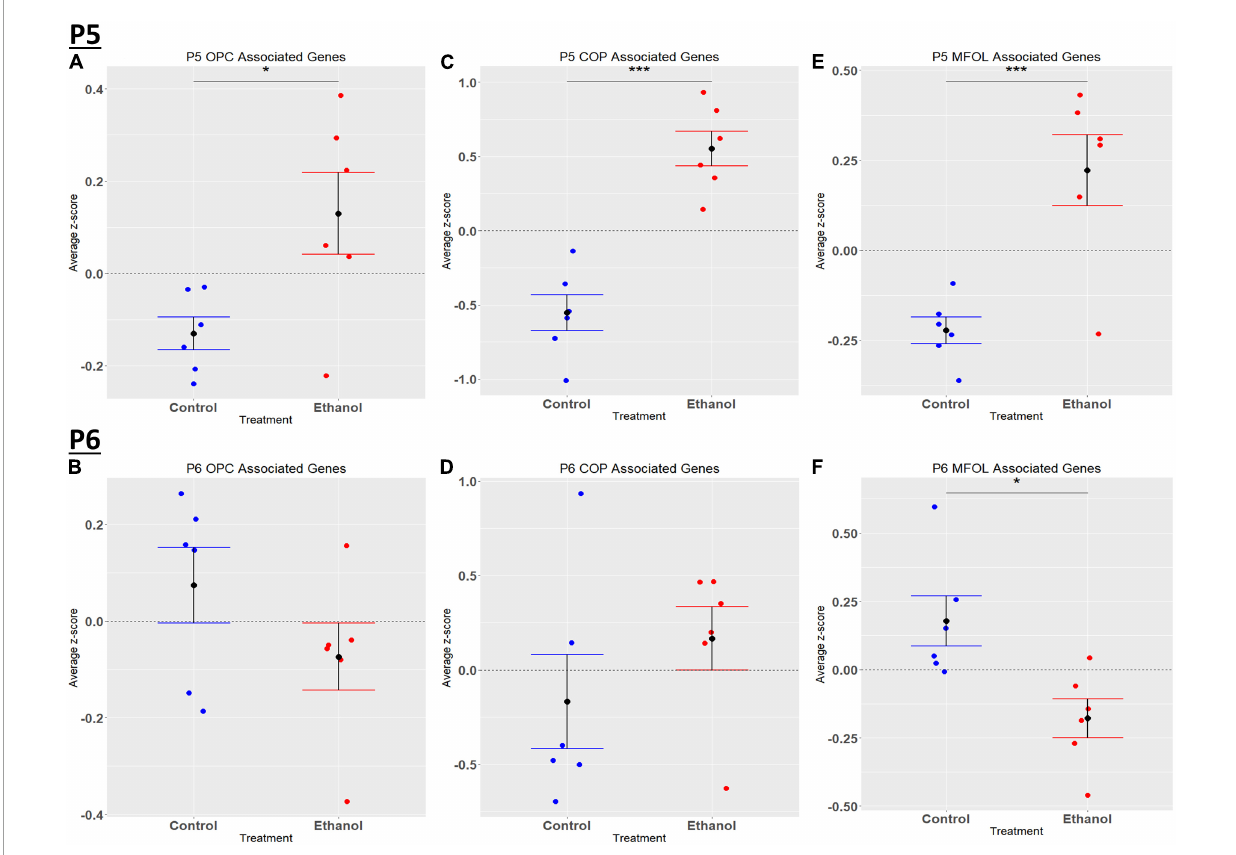
FIGURE8 Oligodendrocyte lineage associated altered genes by ethanol exposure at P5 and P6 in the cerebellum. Oligodendrocyte lineage associated genes were extracted as detailed in Methods. R statistical software was utilized to generate individual z -scores for each transcript of interest and each experimental animal. These z -scores were then averaged across transcripts for each individual animal. Quantification by average z-score of OPC associated genes at P5 (A) and P6 (B) , COP associated genes at P5 (C) and P6 (D) , and MFOL associated genes at P5 (E) and P6 (F) . n = 3 males and 3 females per treatment group E or C; * p < 0.05, *** p <